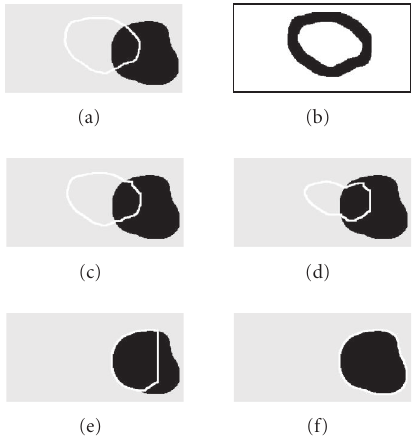
Figure 2: The segmentation result on a 2D synthetic image based on dual-front active contours. (a) The original image and the initial curve (the red line), (b) the black region is the defined active re- gion which is extended from the initial curve using morphological dilation, (c) the new formed global partition curve within the active region after dual-front evolution, (d) to (f) the di ff erent new global minimal partition curves after 5, 10, 15